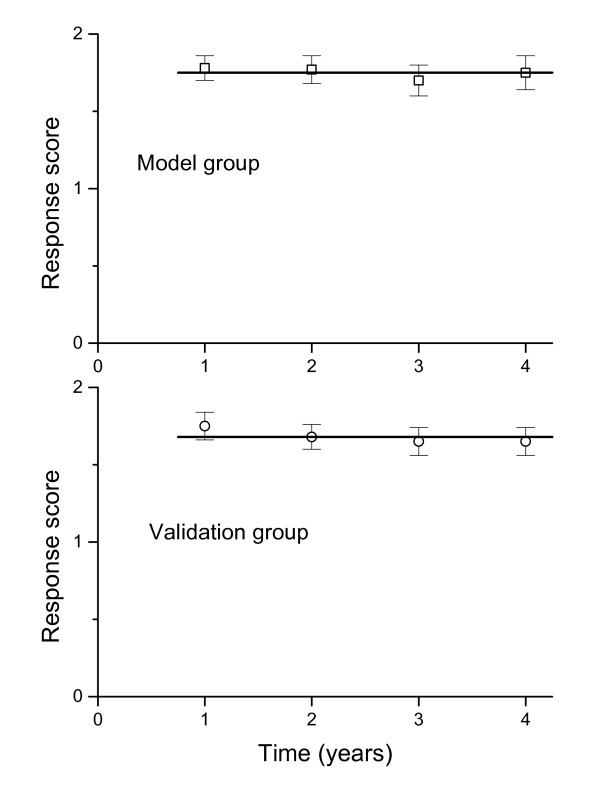
The group mean values ± SEM for the Response Score calculated at 1, 2, 3 and 4 years of GH treatment. The equation was applied to data from children who have values from all four annual measurements on GH treatment: the model group (n = 51) and validation group (n = 54). The observed height at the yearly measurement is used for estimation of the RS (1–4 years). This shows that a reliable model gives constant RS values during 4 years of GH treatment.